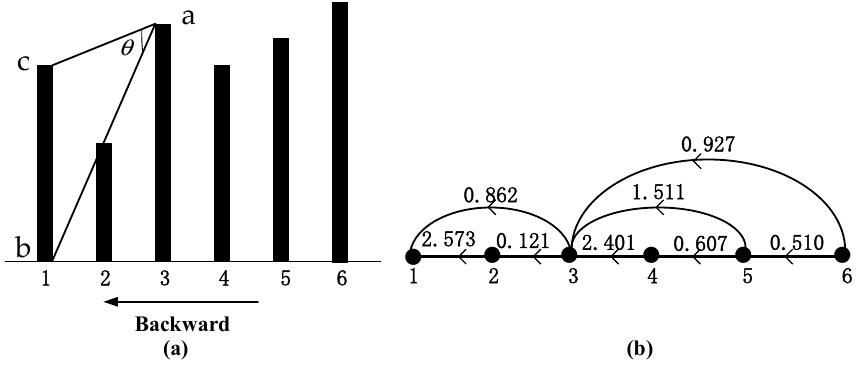
Figure 3. Graphical illustration of FWHVG of the time series. ( a ) Angle measurement of FWHVG; ( b ) Corresponding FWHVG of the time series.